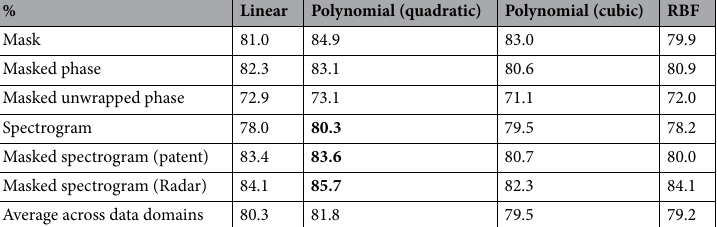
Table 4. Classifications accuracy in % for different SVM kernel functions and different data